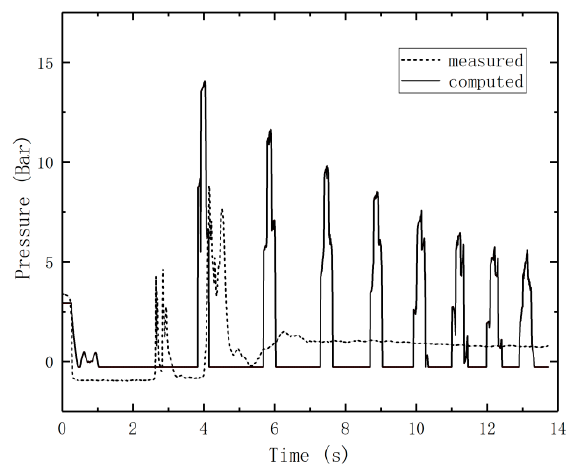
Figure 5. Comparisons of measured and simulated pressures at the Number 4 measurement point before optimization.